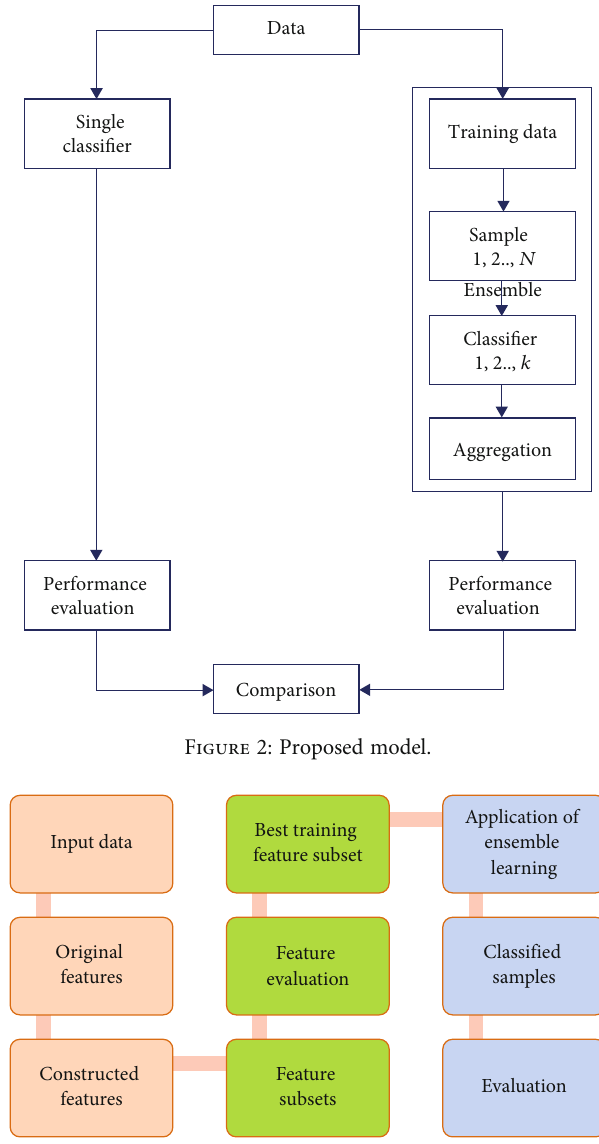
Figure 3: Feature